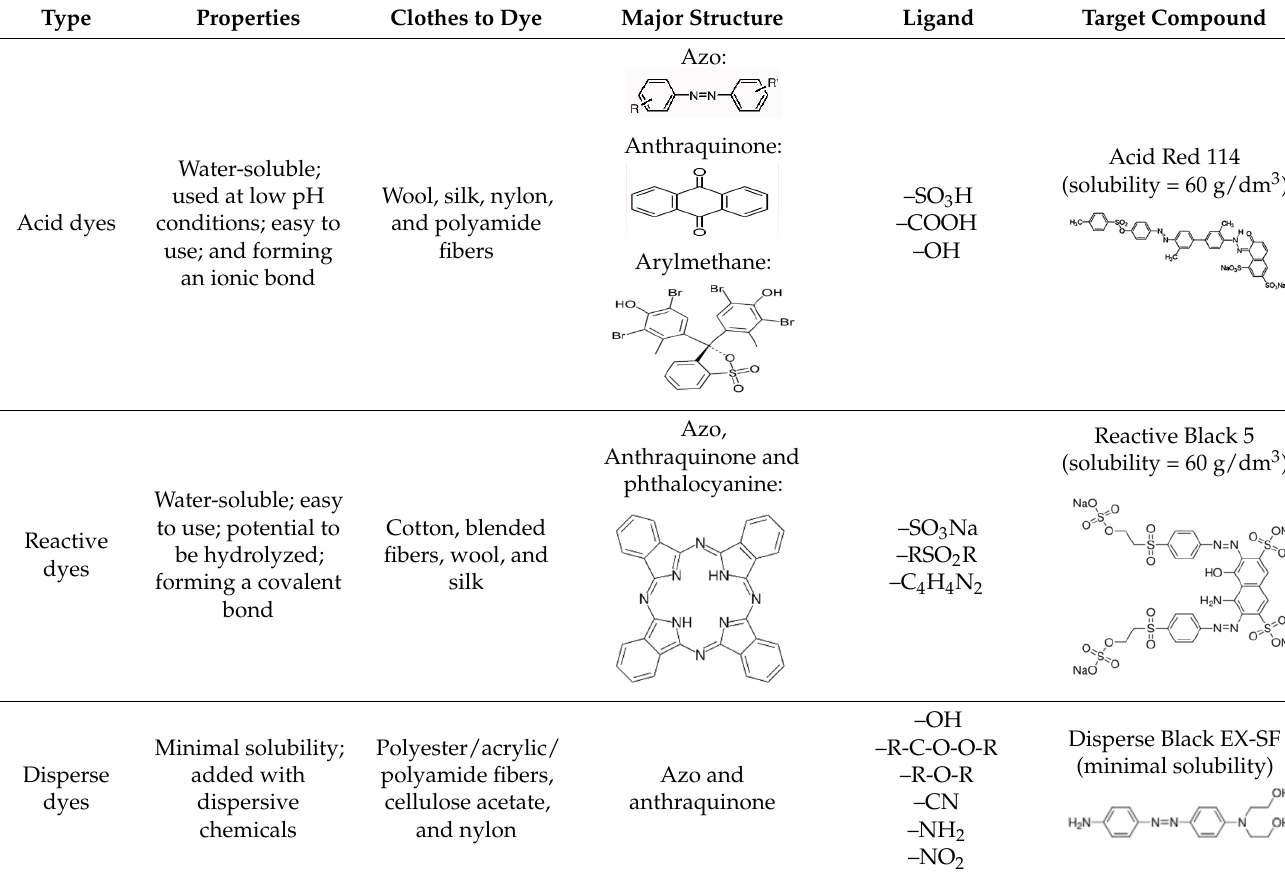
Table 1. Examples of commonly used dyes in the studied dyeing company, including acid, reactive, and disperse dyes.